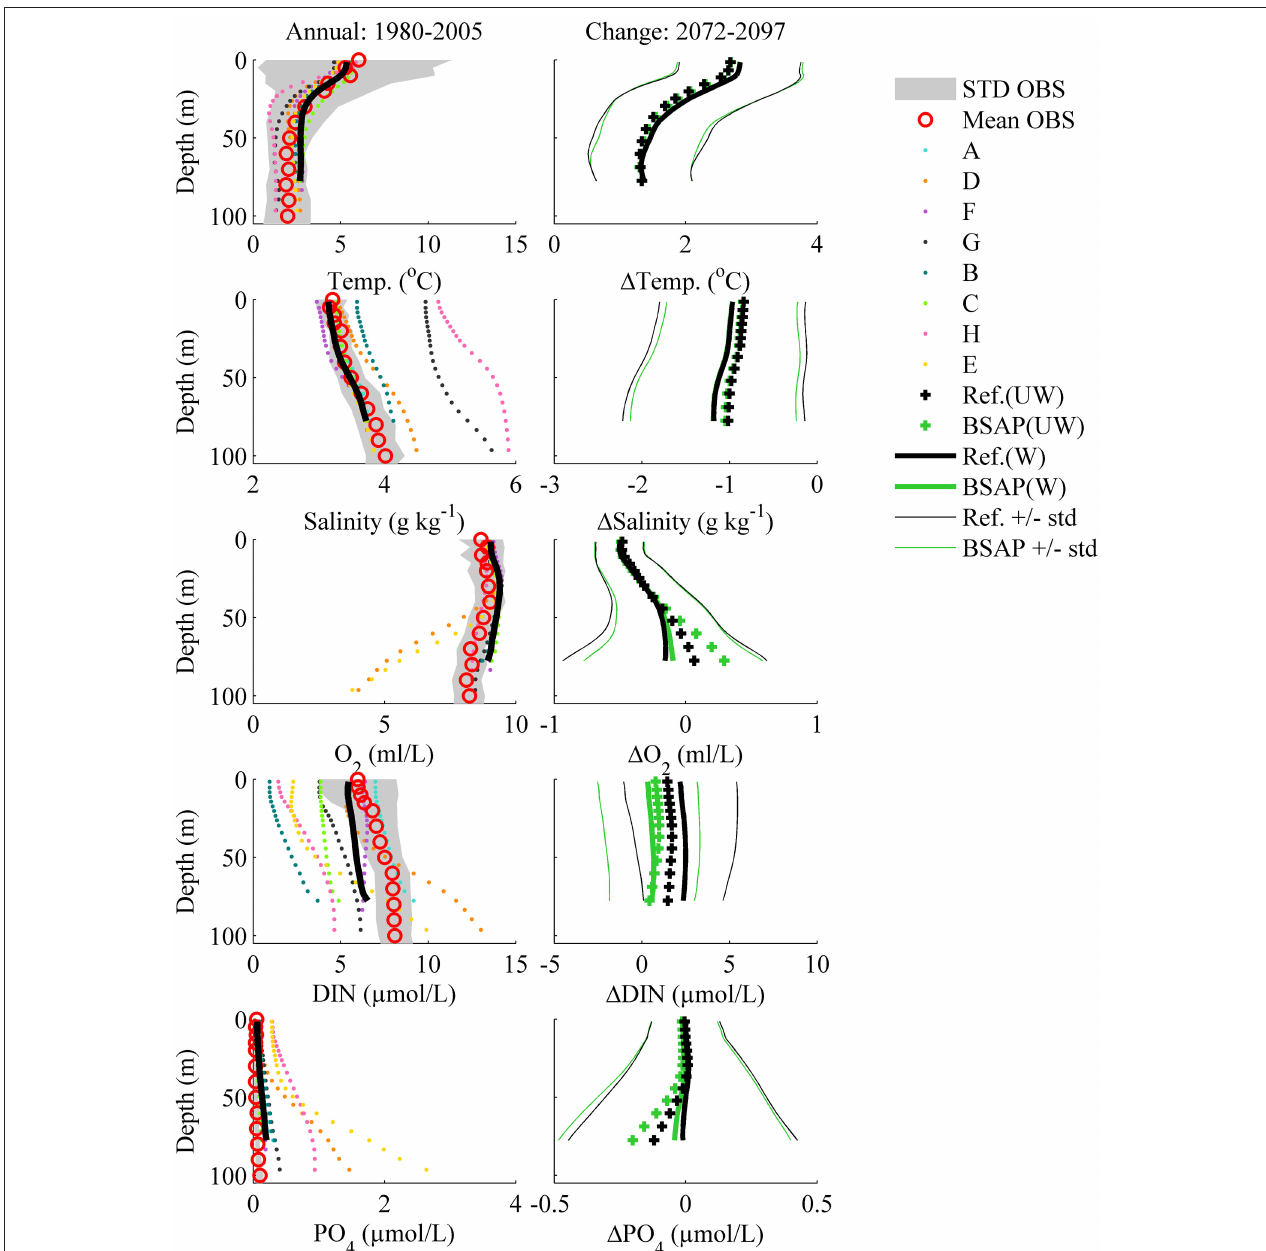
FIGURE 13 | Mean observed and simulated profiles in the control runs for each variable and each Model A to H at F9 in the Bothnian Bay for the period 1980–2005 (left panels). The ensemble mean value (thick black line) is calculated from the weighted model results. In addition, the unweighted (plus signs) and weighted (thick solid lines) ensemble mean changes and standard deviations between the future (2072–2097) and present (1980–2005) climates in REF and BSAP scenario simulations are shown (right panels). Standard deviations are calculated from the two ensembles without